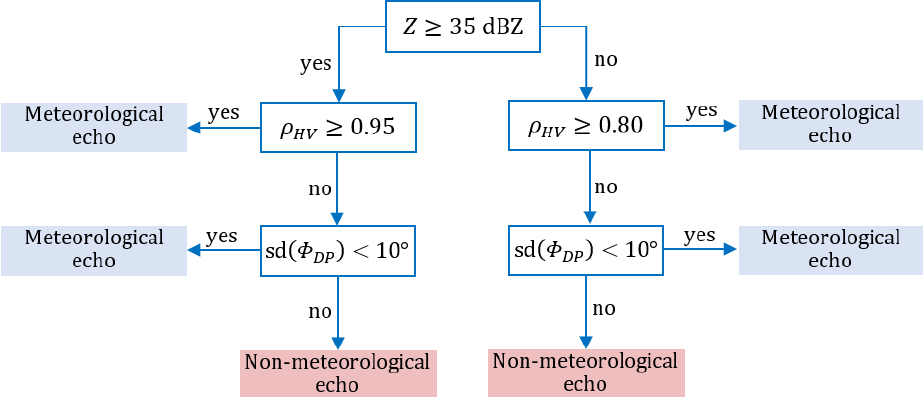
Figure 6. Flowchart describing the DP.NMET algorithm designed to detect non-meteorological echoes of different types for dual-polarization radars (based on the scheme from Seo et al.,